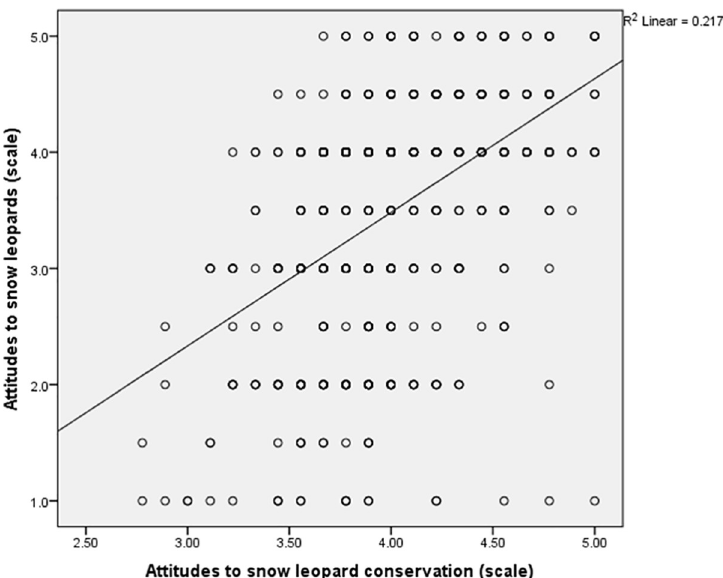
Fig 2. Scatterplot showing a strong positive relationship between attitudes to snow leopard conservation and attitudes to snow leopards. N = 678. Scales comprised means from reverse-scored five-point Likert scale questions. Snow leopard attitudinal scale components: snow leopards; future presence of snow leopards; Cronbach’s alpha = 0.878. Snow leopard conservation attitudinal scale components comprise: park management; local conservation committee; snow leopard killing ban; snow leopard prey killing ban; livestock compensation scheme; corral construction; environmental education; non-timber forest product collection limits; wood collection limits; Cronbach’s alpha =